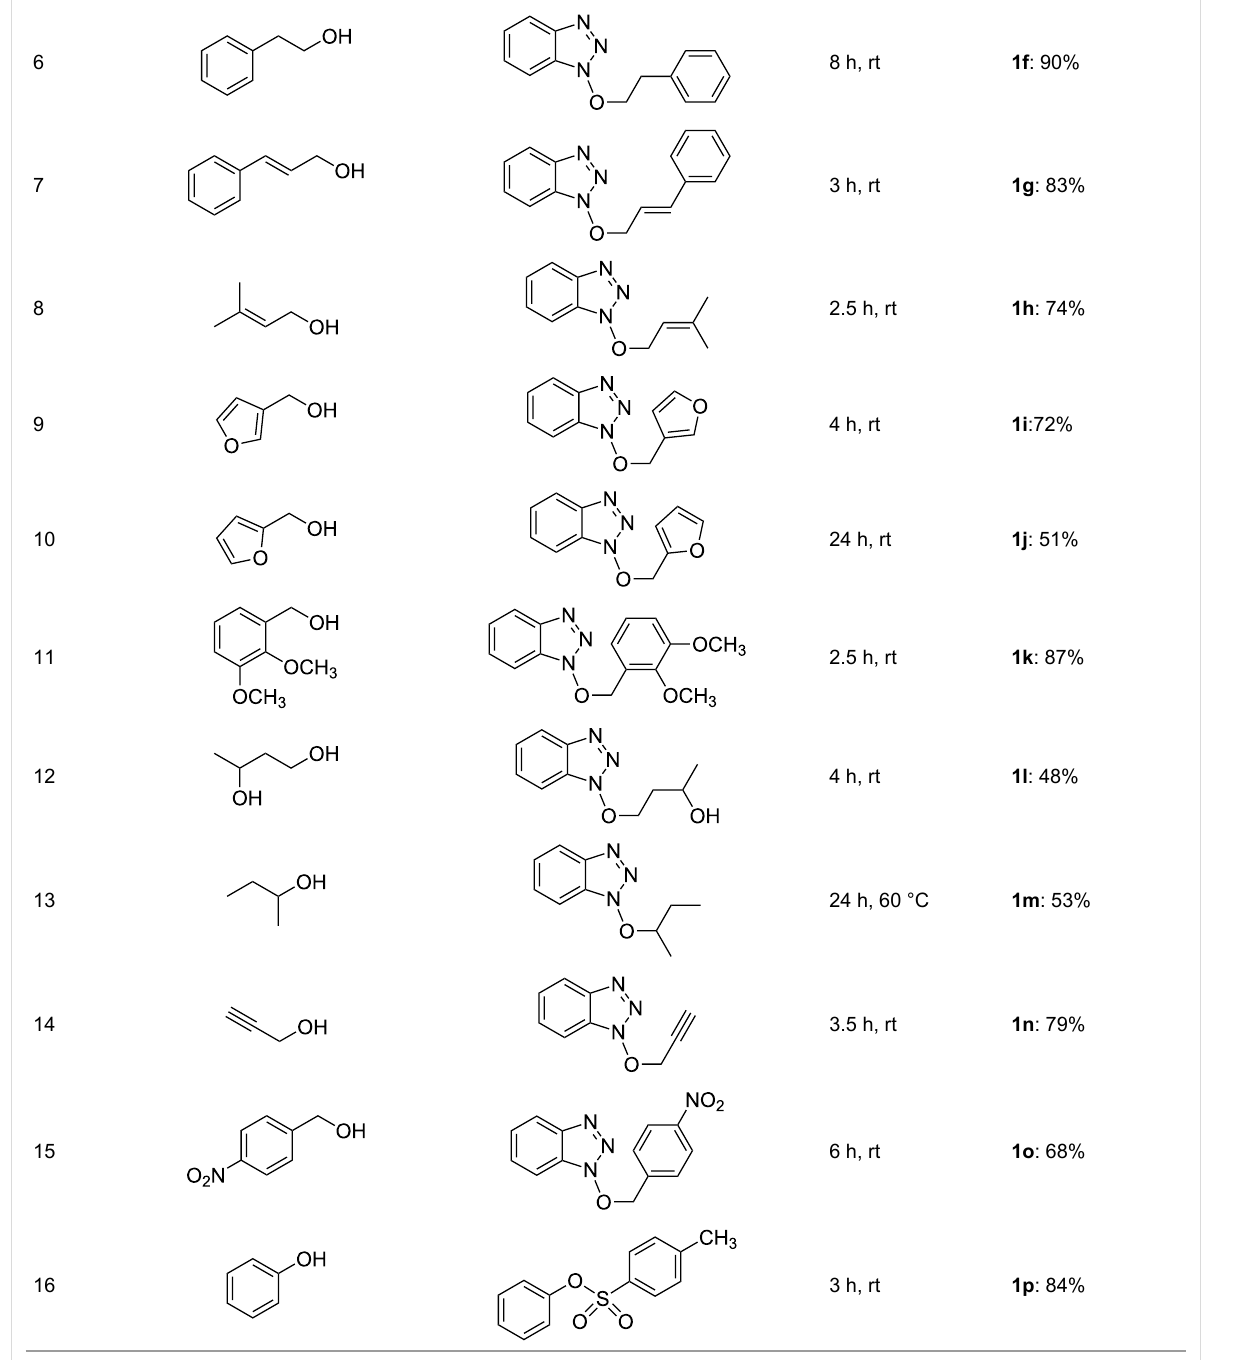
Table 2: Reactions of various alcohols with Bt-OTs.